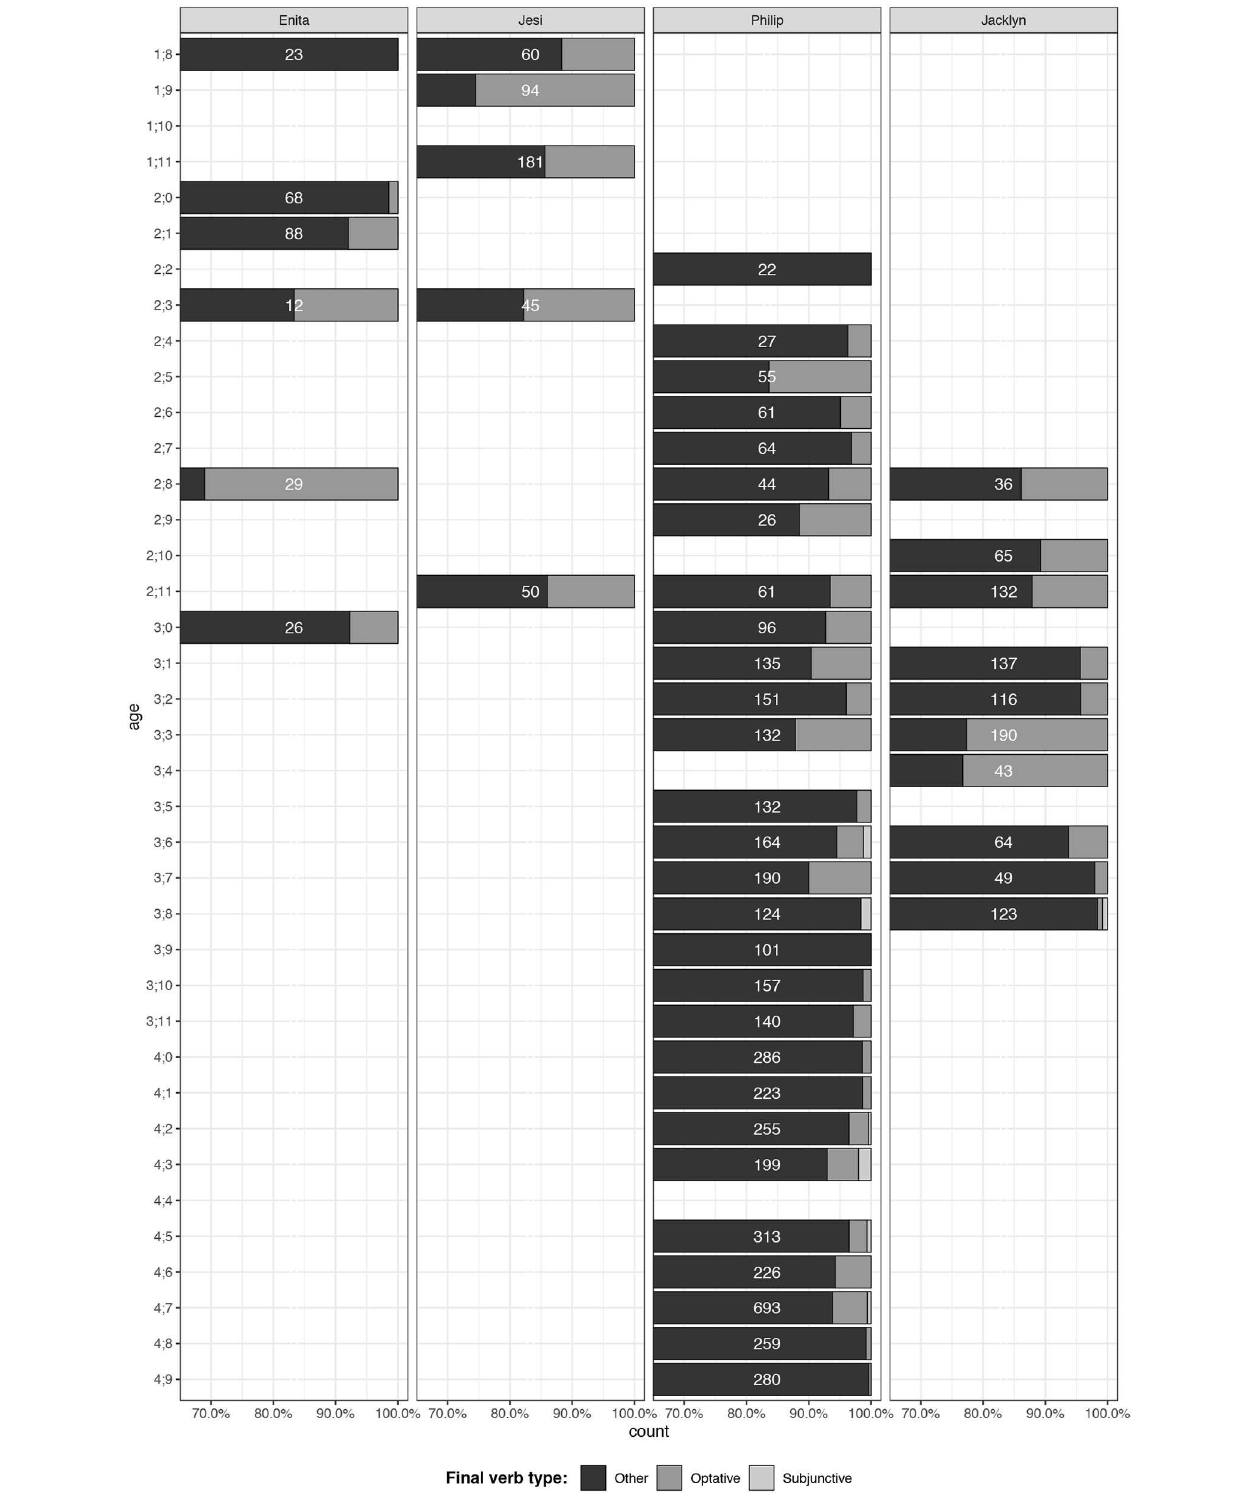
FIGURE 3 | Proportions of Optative and Subjunctive vs. other clause chain-final verbs in the children’s speech.